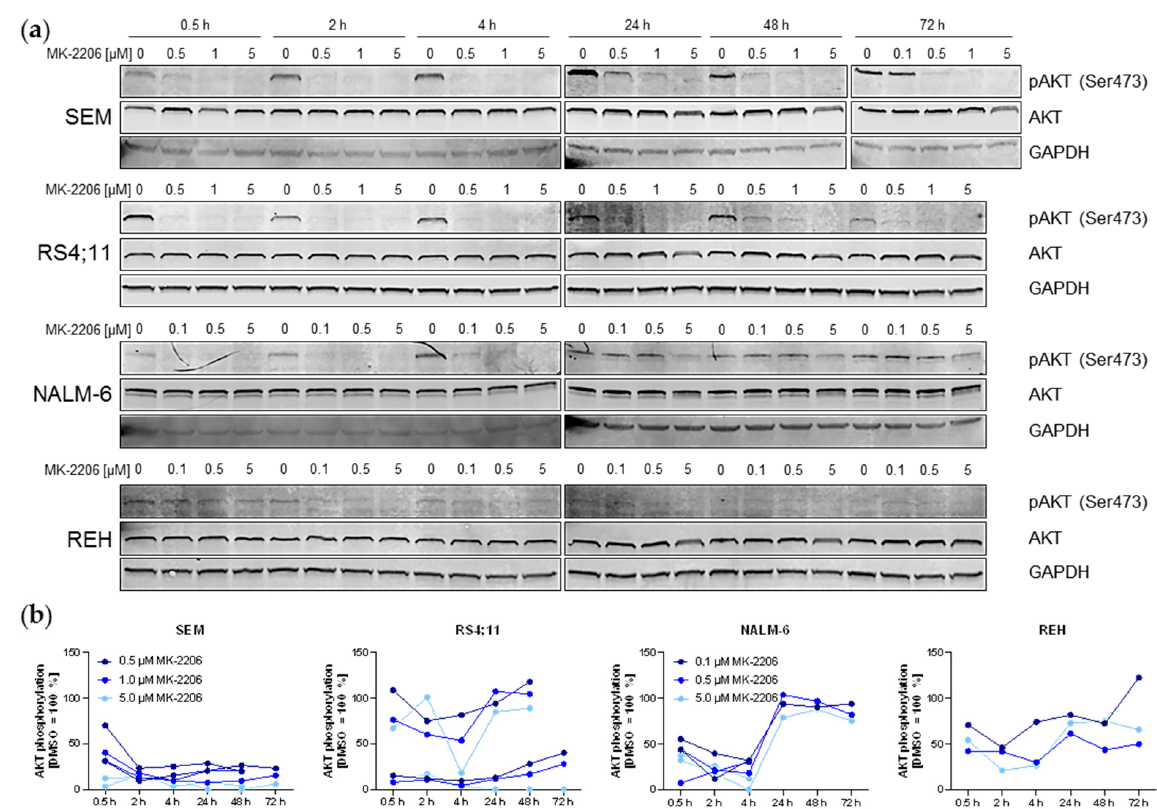
Figure 1. Expression of phosphorylated and total AKT protein determined by immunoblot and subsequent quantification. ( a ) SEM, RS4;11, REH and NALM-6 cells were incubated with the stated concentrations of MK-2206 for the indicated time periods. The displayed immunoblots are representative captions of at least two individual biological replicates. GAPDH was used as internal loading control. Blots were processed and cropped using Image Studio Lite 5.2 software and MS PowerPoint (2011) to improve clarity and conciseness. ( b ) Phospho (p)-AKT and total AKT band intensities of two independent biological replicates including the blots shown in Figure 1a were determined using Image Studio Lite 5.2 software. AKT phosphorylation was calculated as the ratio of pAKT/total AKT and normalized to the DMSO control separately for every time point. One REH replicate was not quantified due to the very low basal pAKT expression and therefore low signal to noise ratio not acceptable for reliable quantification.